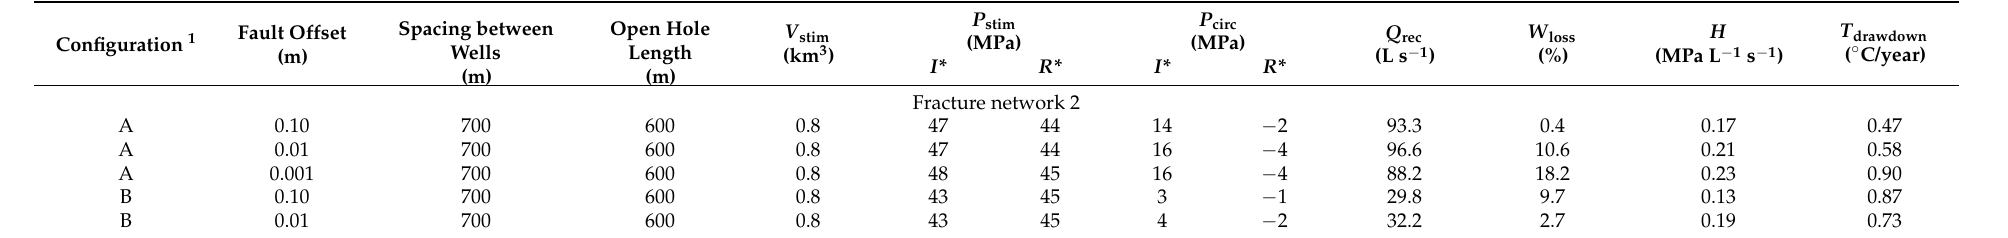
Table 5. Design parameters and